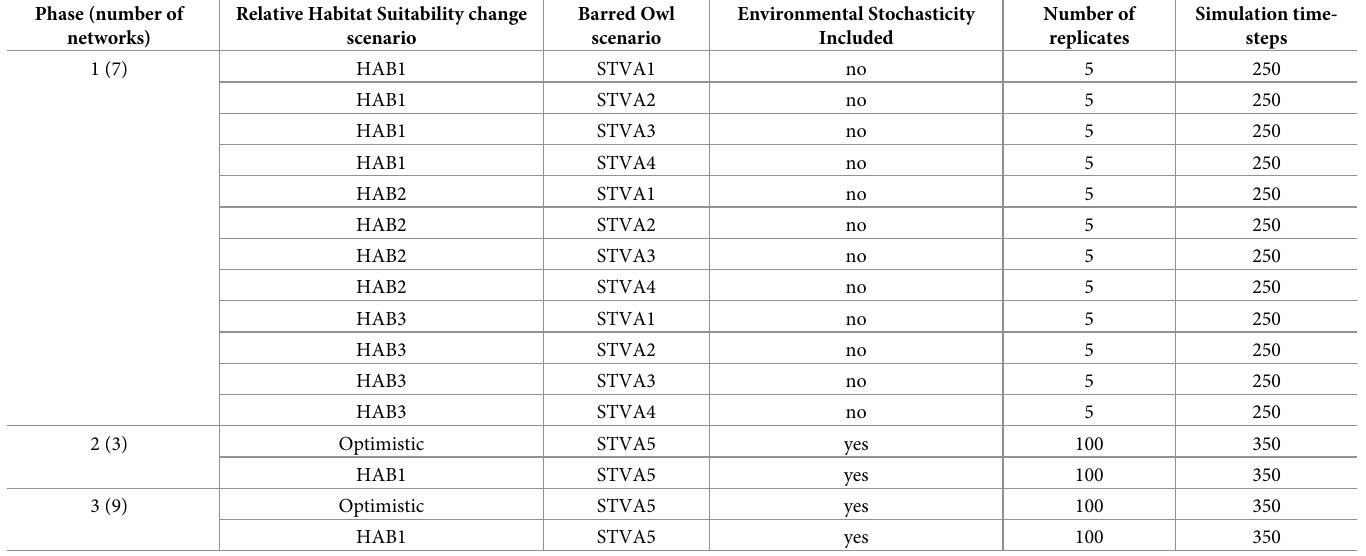
Table 4. Number of alternative candidate critical habitat networks by relative habitat suitability by barred owl scenarios, inclusion of environmental stochasticity, number of replicates, and total time steps used in HexSim simulations of northern spotted owl populations. Phase (number of Relative Habitat Suitability change Barred Owl Environmental Stochasticity Number of Simulation time- networks) scenario scenario Included replicates